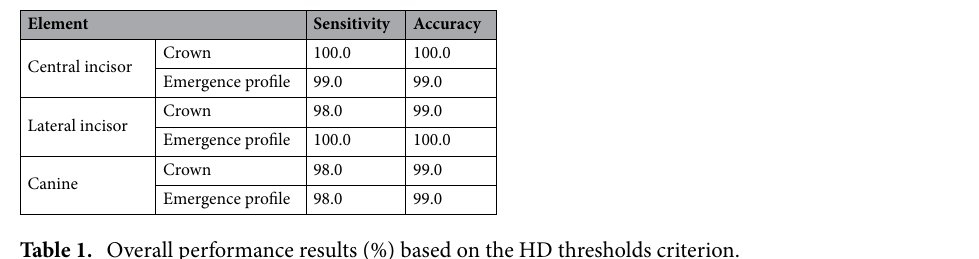
Table 1. Overall performance results (%) based on the HD thresholds